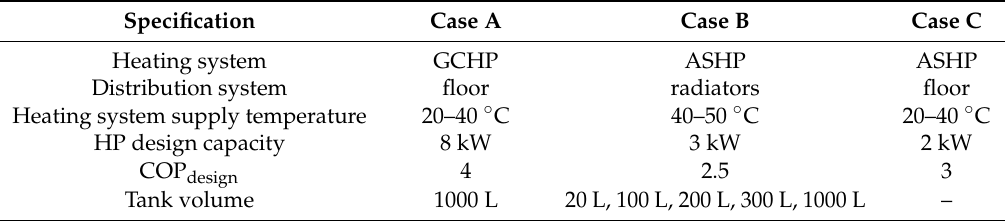
Table 3. Design parameters of the heating